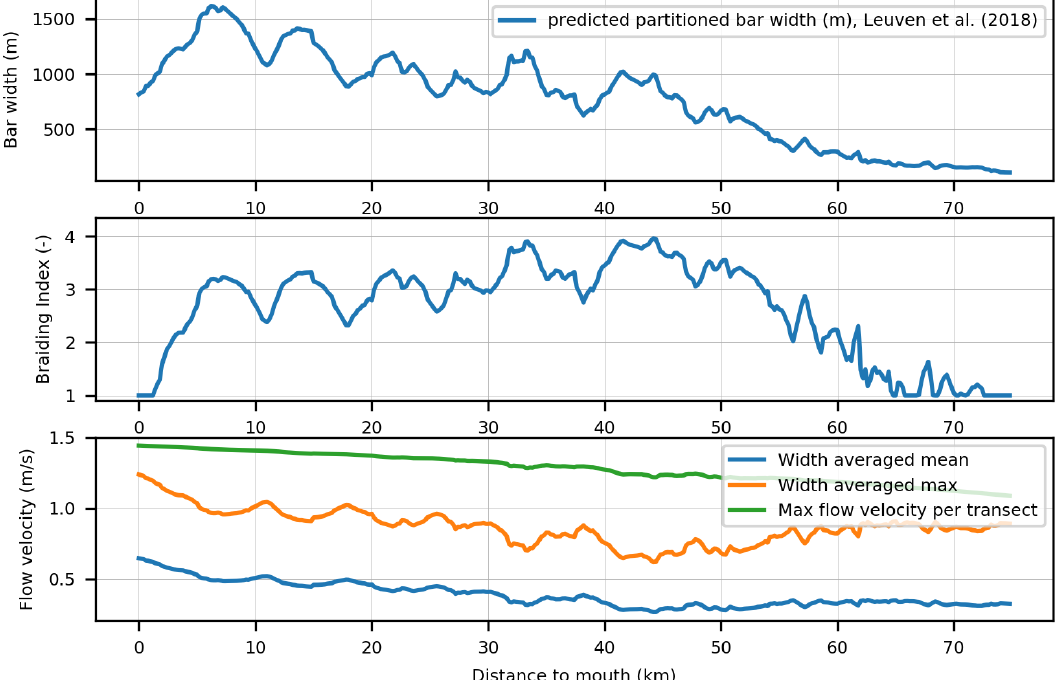
Figure A3. Tool output for the Western Scheldt. ( top ) predicted along-channel bar width, ( middle ) predicted along-channel braiding index and ( bottom ) the cross-sectional maximum and average of the predicted along-channel peak tidal flow velocity and the cross-sectional average of the mean flow velocity over half a tidal